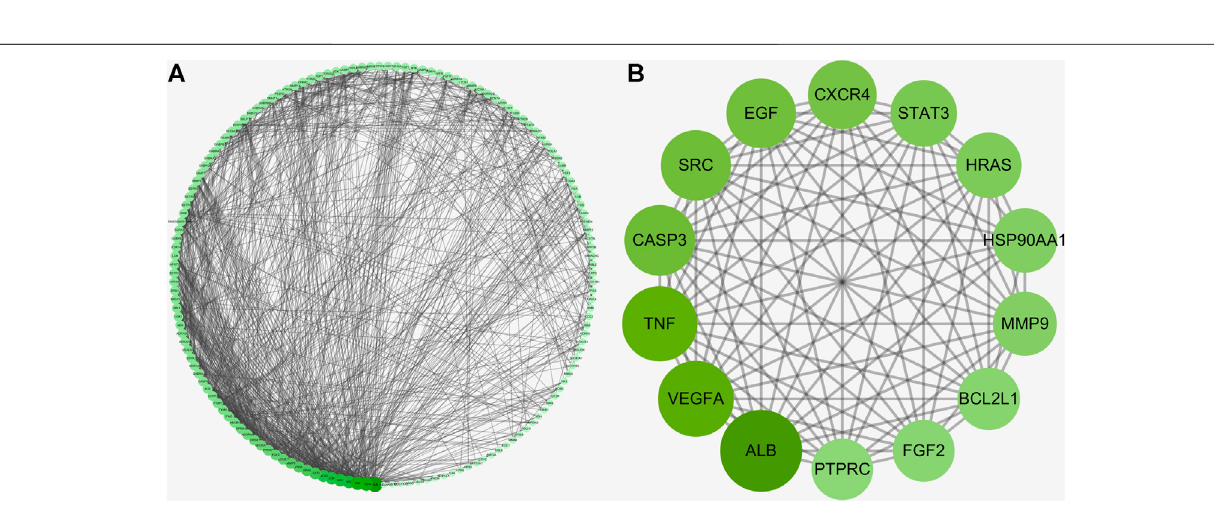
Frontiers in Pharmacology |